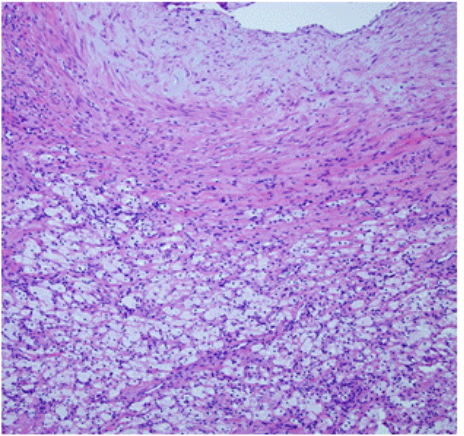
FIGURE 3. Histology showing XGP with characteristic xanthoma cells present surrounding and invading the IVC.